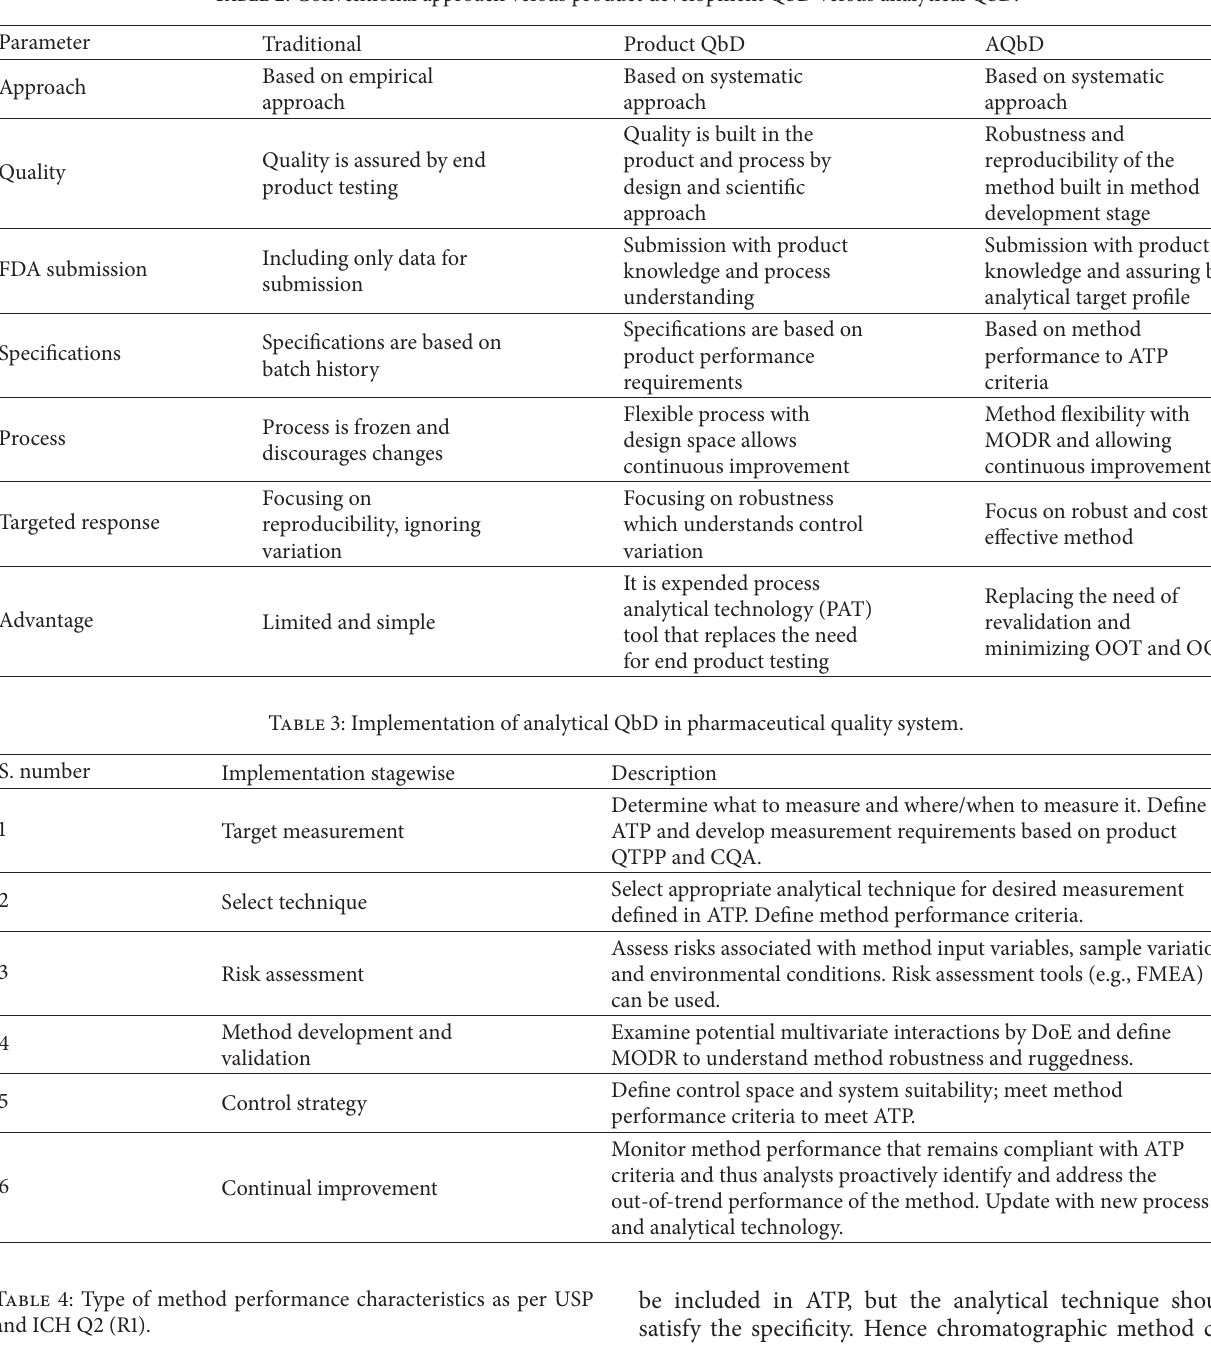
Table 2: Conventional approach versus product development QbD versus analytical QbD.